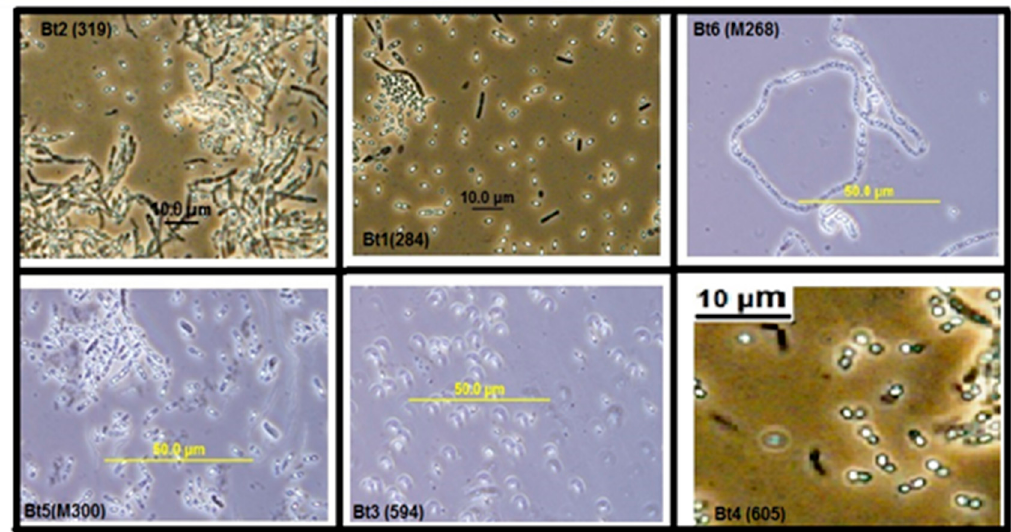
Figure 1. Phase contrast micrographs of some native Bt isolates. Morphology of parasporal crystals from Bt1, Bt2, Bt3, Bt4, Bt5, Bt6 is bi-pyramidal, spherical, small bi-pyramidal, attached crystals, ovoid and hexagonal, respectively. Within 'parentheses' are their respective original identification numbers.